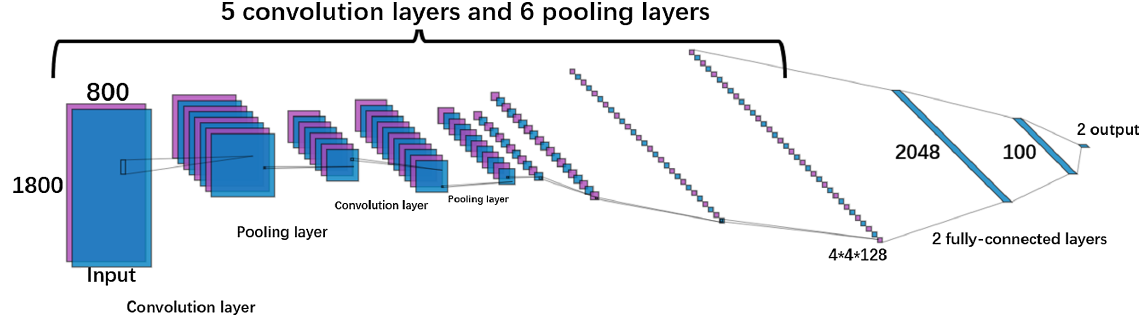
FIG. 3. The structure of the convolutional neural network built in this experiment which consisting of one input layer, five convolutional layers, six pooling layers, two fully connected layers, and one output layer.